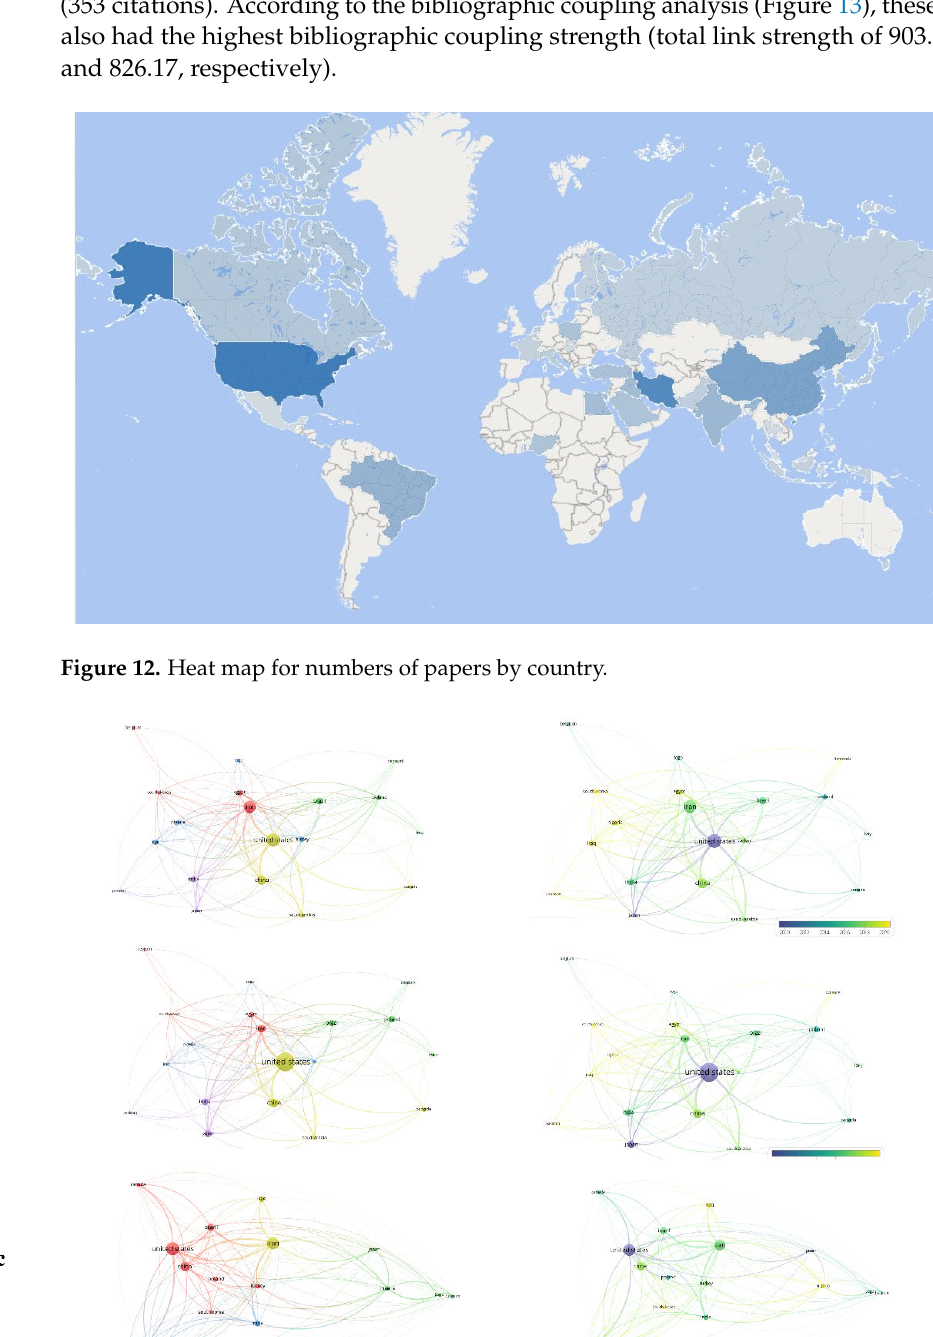
Figure 13. Network of countries based on numbers of documents, citations, and bibliographic cou- pling.